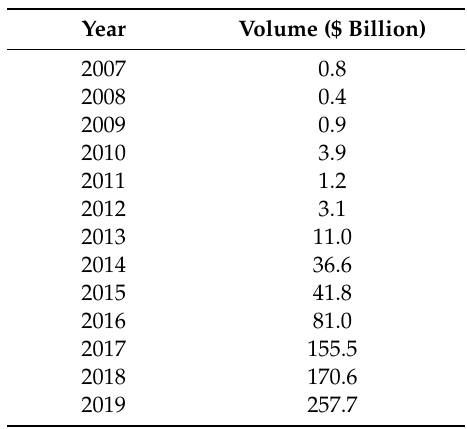
Table 1. Annual issuance of green